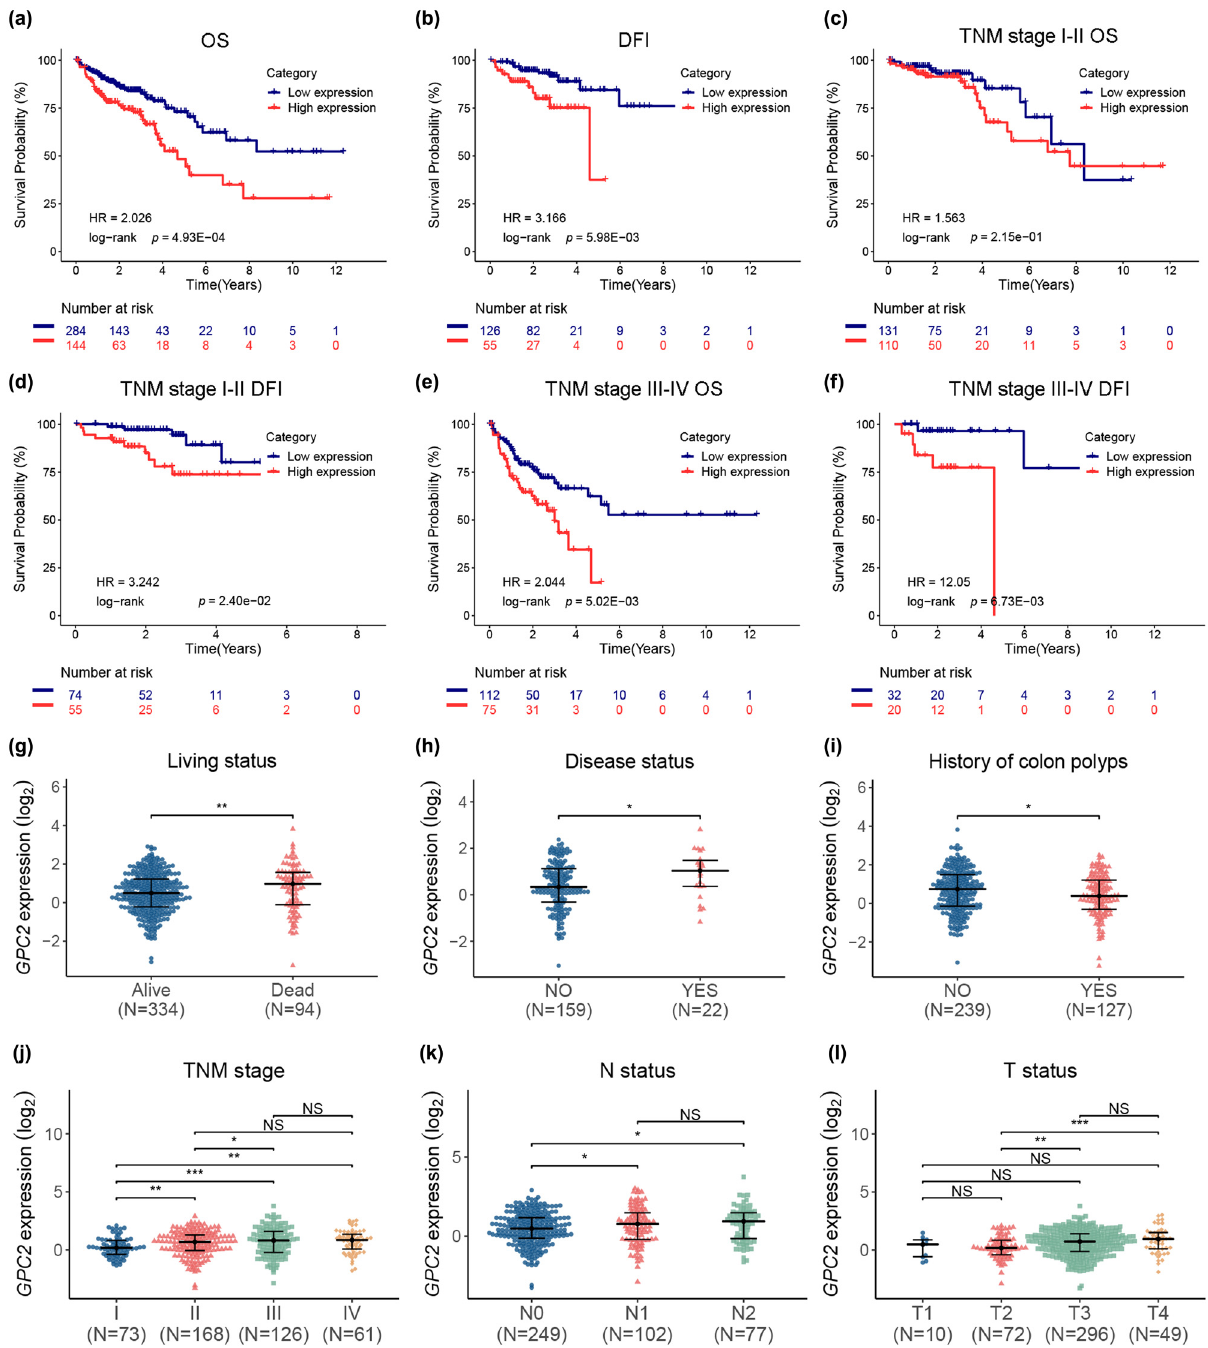
Figure 2: High transcription levels of GPC2 suggest a poor prognosis in patients with COAD: ( a and b ) correlation between GPC2 expression and the OS ( a; low expression: n = 284; high expression: n = 144 ) or DFI ( b; low expression: n = 126; high expression: n = 55 ) of total patients with COAD was analyzed using KM analysis, ( c – f ) the relationship between GPC2 level and patients ’ OS ( c and e ) and DFI ( d and f ) was analyzed by KM curve based on TNM stage. TNM stage I – II OS: Low expression: n = 131; High expression: n = 110; TNM stage I – II